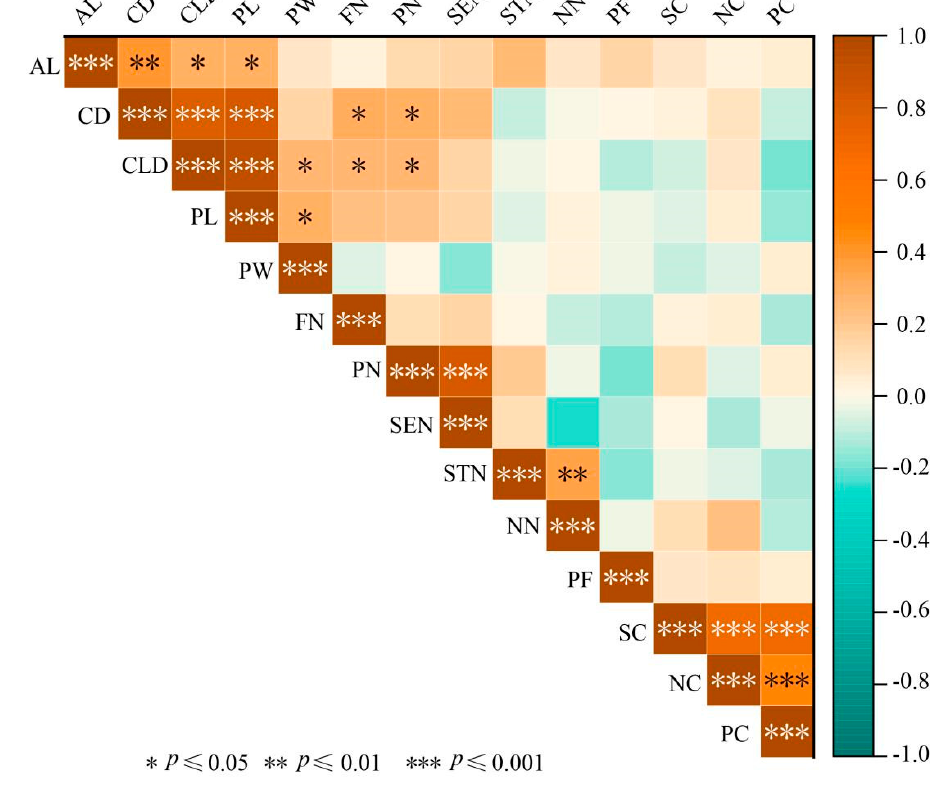
Figure 2. Correlation coefficients of phenotypic traits in 60 plants of L. chinense var. rubrum . Note: Yellow-brown indicates a positive correlation; light blue indicates a negative correlation; the darker the color, the stronger the correlation.